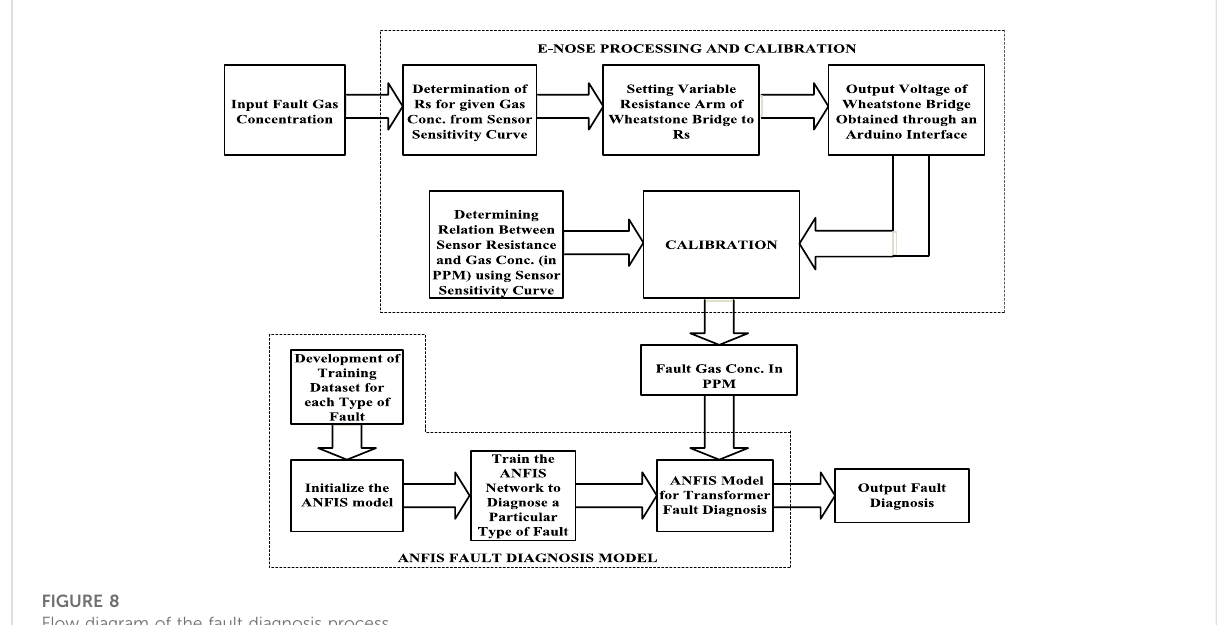
FIGURE 8 Flow diagram of the fault diagnosis process.